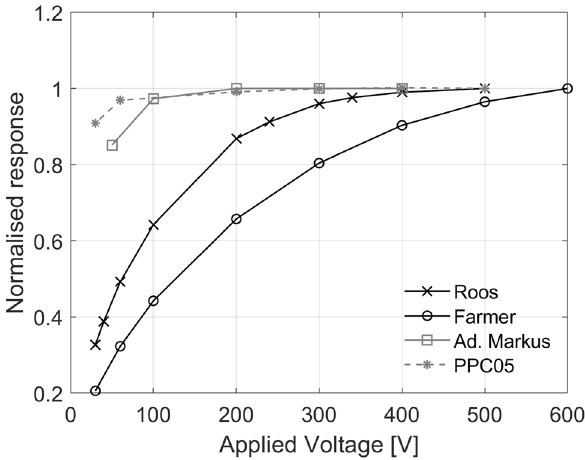
Figure 3. Normalised saturation curves measured for various ionisation chamber types. Data were normalised to the averaged measured signal for the maximum applied voltage for each ionisation chamber type. Note that the PTW Farmer operated at 600 V has not reached saturation.